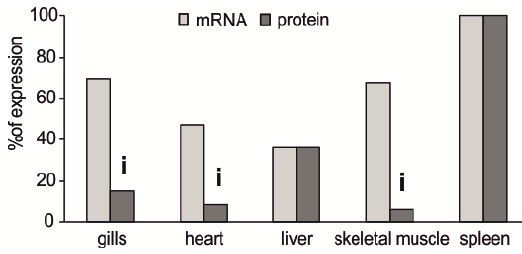
Figure 4. Comparison between the relative expressions of SOD1 mRNA and active protein in the gills, heart, liver, spleen, and skeletal muscle of C. hamatus . The symbol “i” above the histogram columns indicates the possible inhibition of translation.